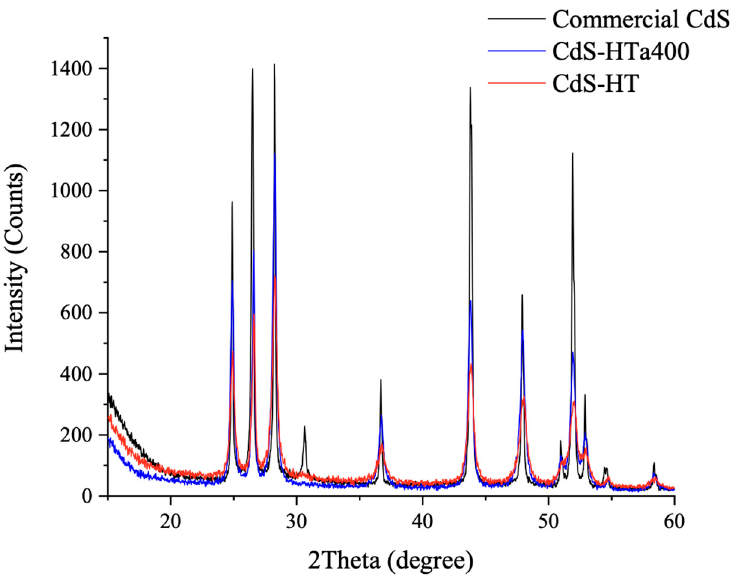
Figure 1. XRD patterns of commercial CdS (black), CdS-HTa400 (blue) and CdS-HT (red). It is observed that after annealing at 400 °C, the powder improves its crystallinity. In